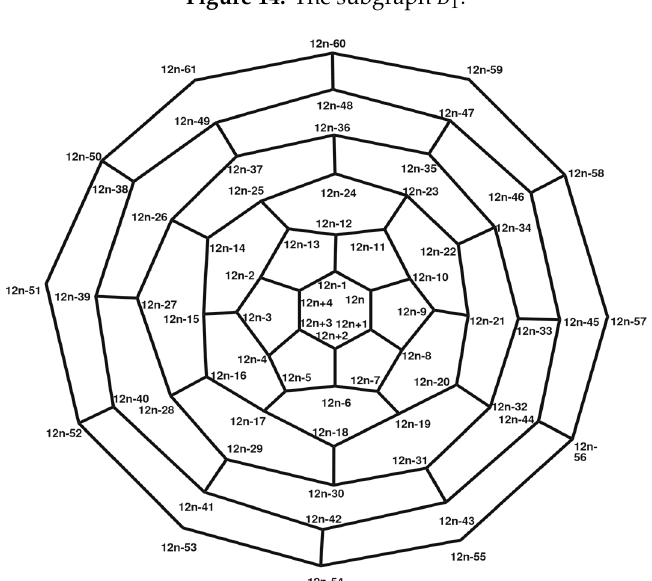
Figure 15. The subgraph B 2 .